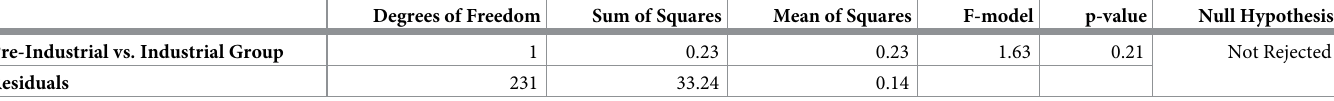
Table 5. Results of permutational test assessing homogeneity of multivariate dispersions for comparison of wear facet area composition between the pre-industrial and industrial groups.